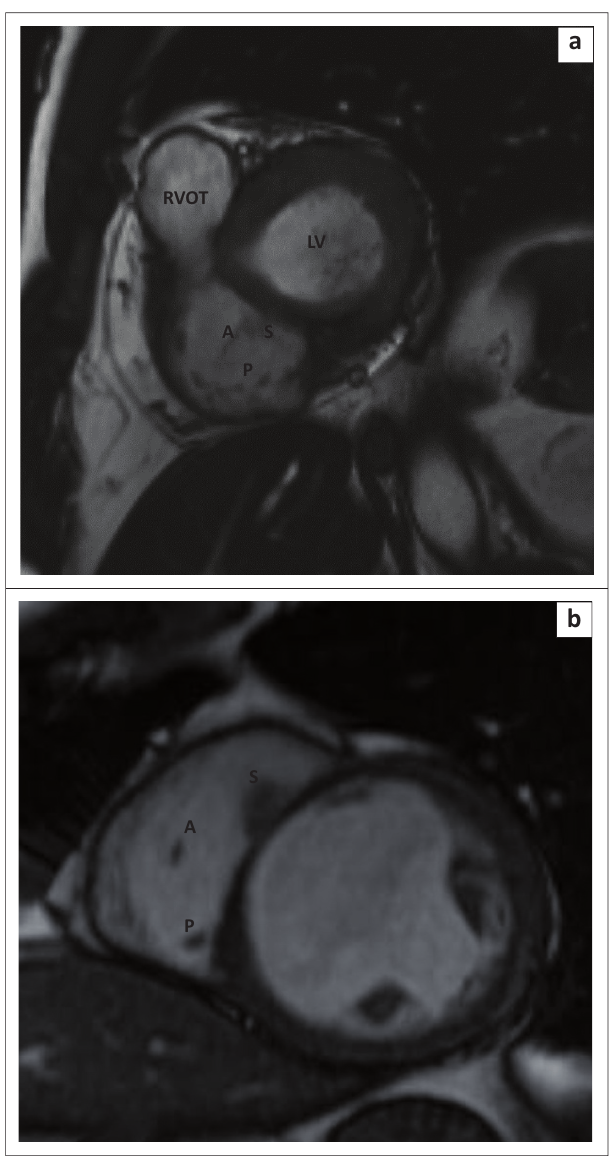
FIGURE 5: (a) Short-axis cine SSFP image of the tricuspid valve demonstrates the anterior (A), septal (S) and posterior (P) leaflets. The left ventricle (LV) and right ventricular outflow tract (RVOT) are identified; (b) Short-axis cine SSFP image demonstrates the anterior (A), septal (S) and posterior (P) papillary muscles of the tricuspid valve.